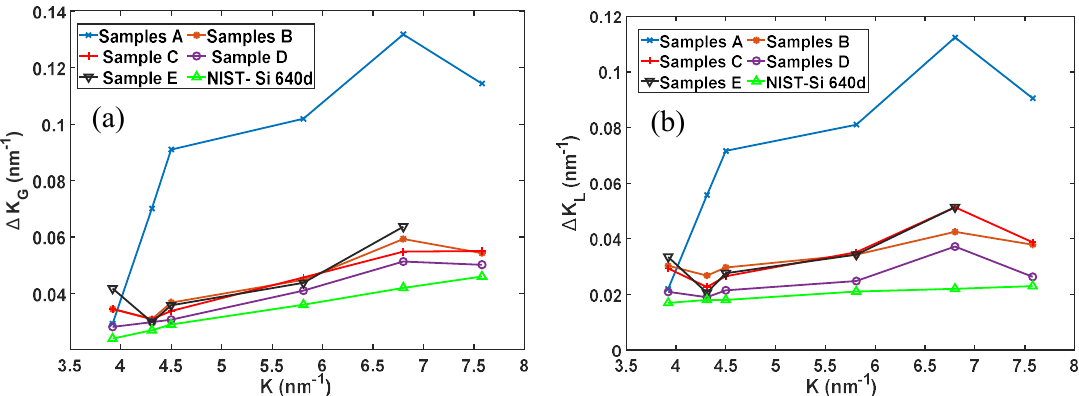
Figure 10. The ( a ) Gaussian and ( b ) Lorentzian FWHM against diffraction vector ( K ) for the five types of the samples with instrumental broadening, referenced against results for a silicon (Si-640d) sample with no instrumental broadening.